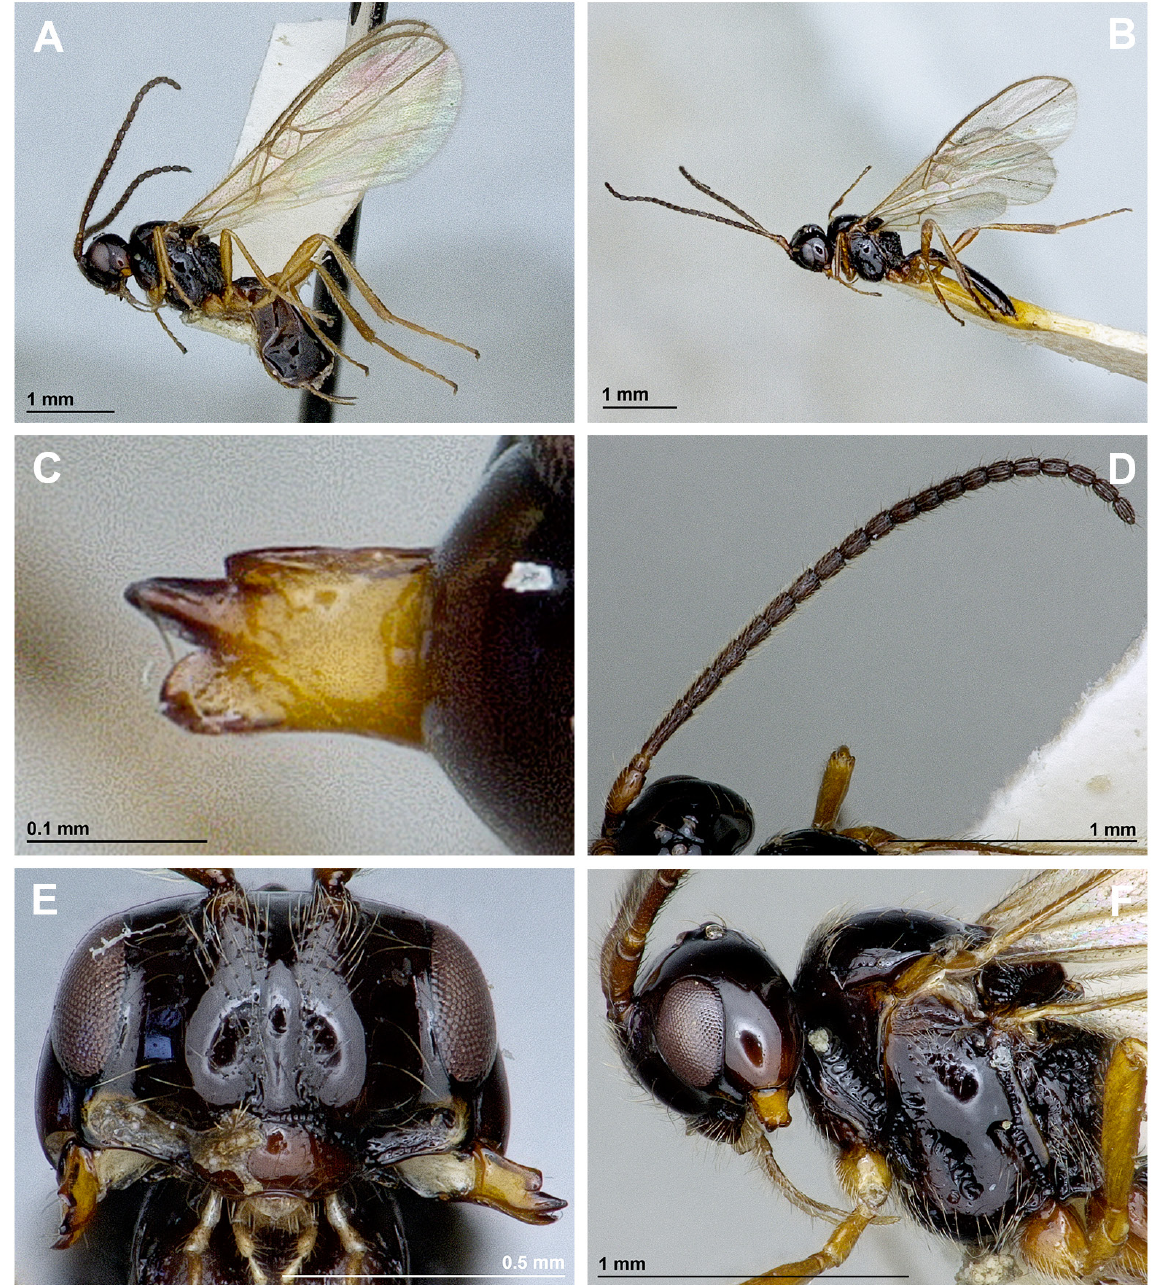
Fig. 2. Aspilota grandis Munk & Peris-Felipo sp. nov. (A, C–F ♀; B ♂). A–B . Habitus, lateral view. C . Mandible. D . Antenna. E . Head, frontal view. F . Head and mesosoma, lateral